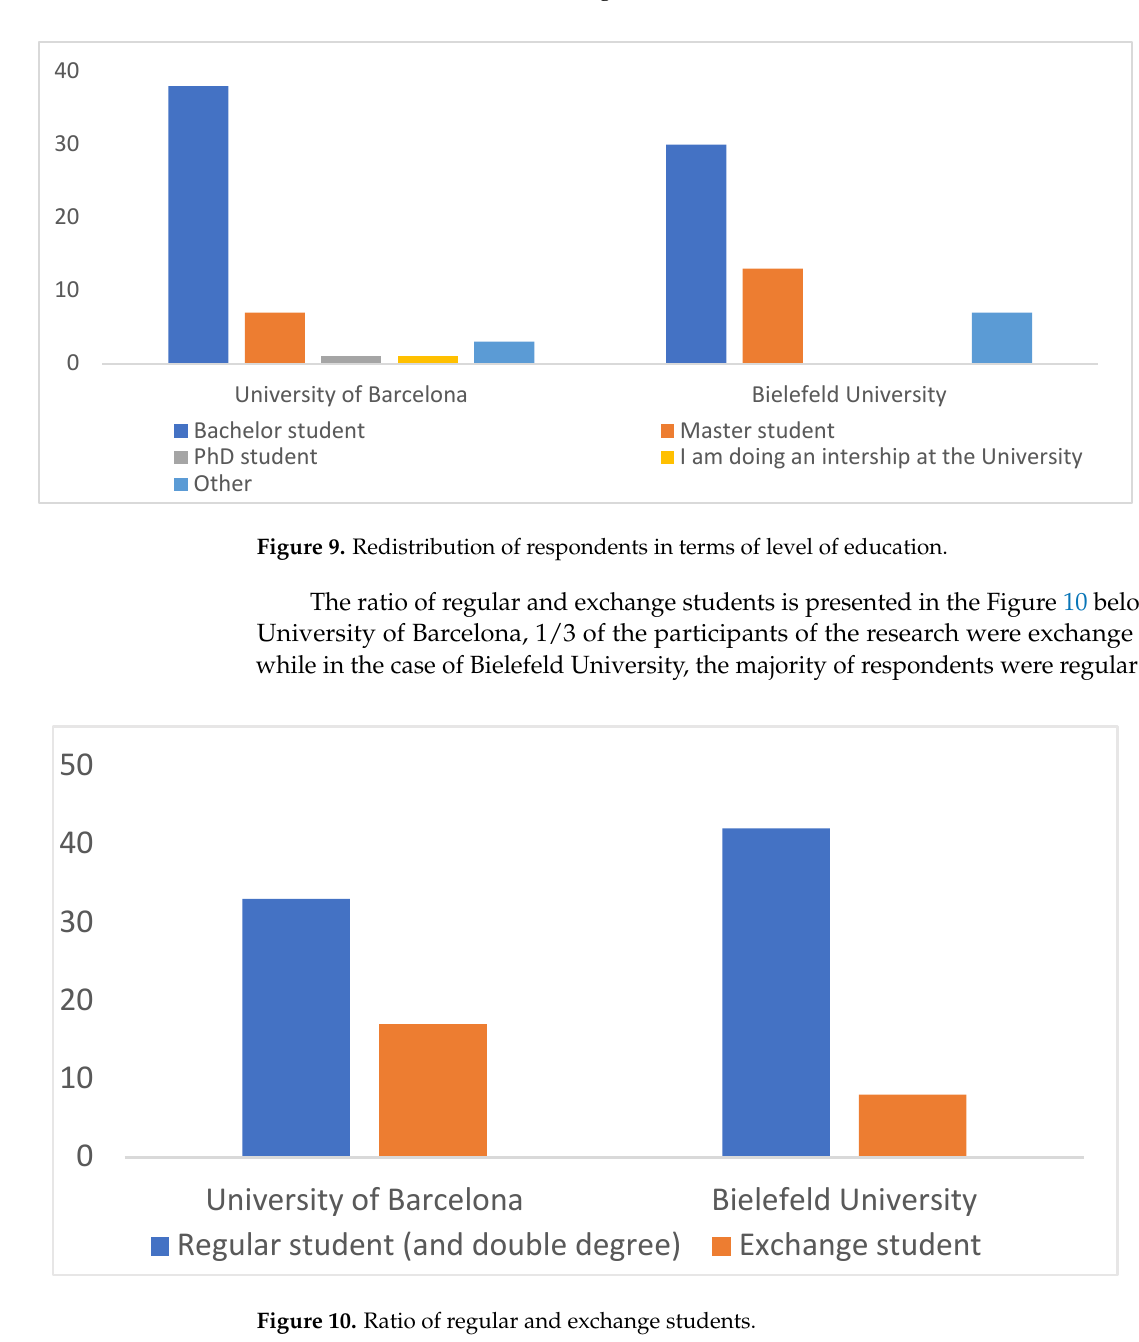
Figure 10. Ratio of regular and exchange students.